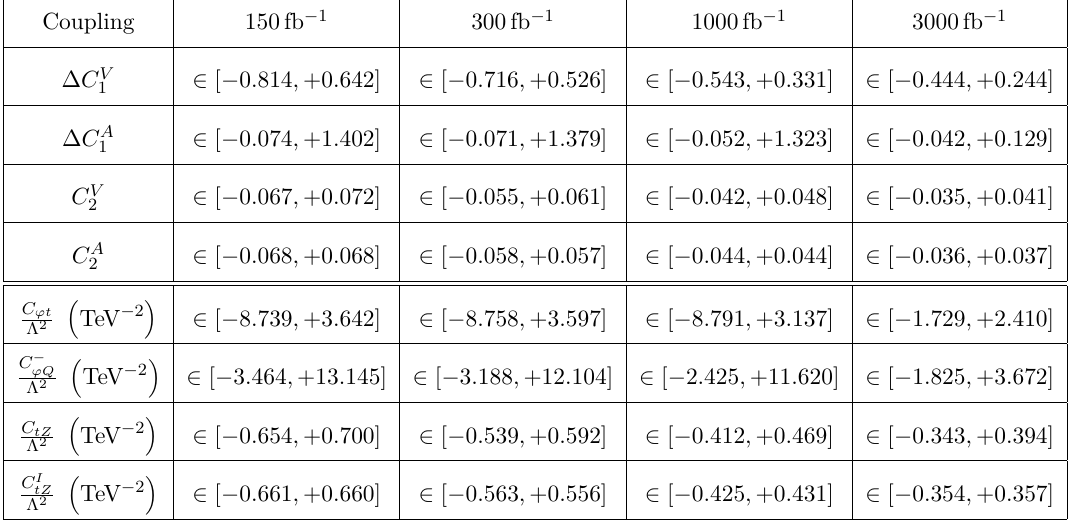
Table 3 . Simultaneous BCI limits at 95% C.L. on the couplings are listed projected in the t ¯ tZ